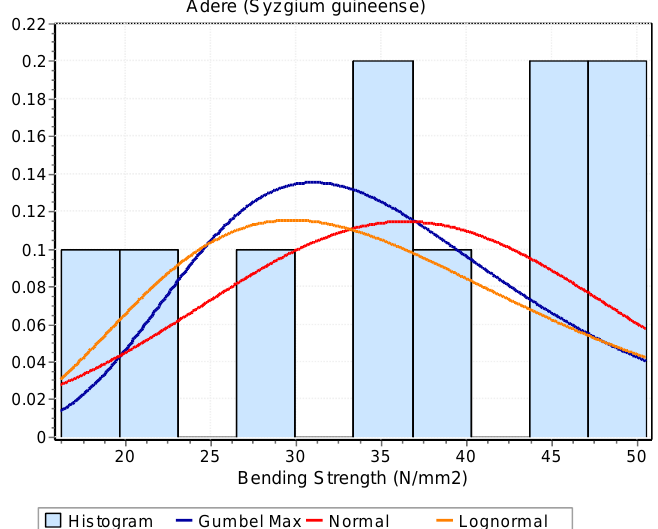
Fig. 8. Probability Density Function Plots for bending strength of Syzium